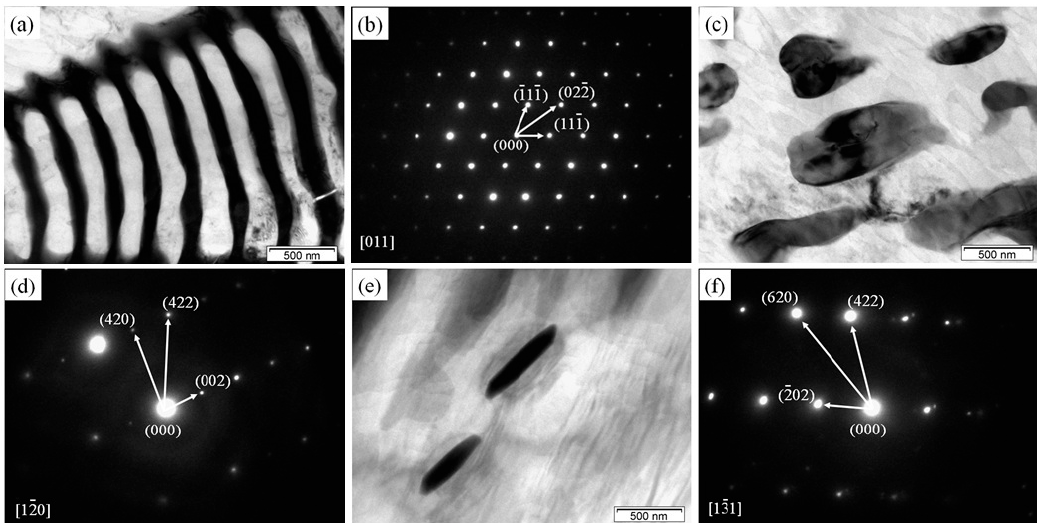
Figure 3. Microstructure of the 3Gd alloy: ( a ) BF TEM image of secondary phase on triple boundary junctions; ( b ) corresponding SAED pattern of ( a ); ( c ) BF TEM of ellipsoid secondary phase; ( d ) corresponding SAED pattern of ( c ); ( e ) BF TEM image of rod-like secondary phase; ( f ) corresponding SAED pattern of ( e ).